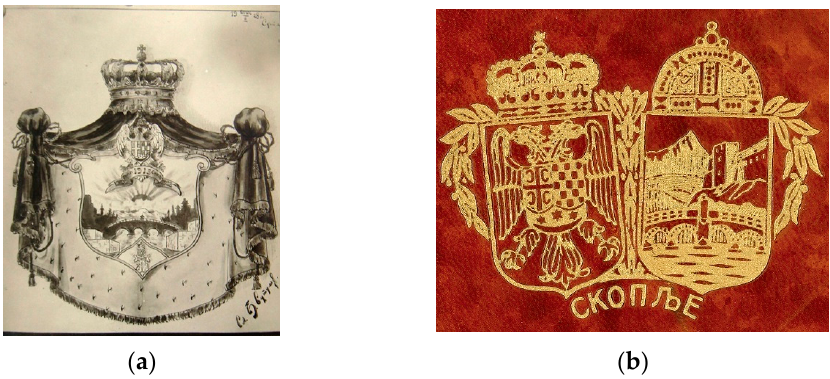
Figure 13. ( a ) “Proposal” for arms of the City of Skopje, 1928; ( b ) King Alexander Karadjordjevic collection (before 1934).